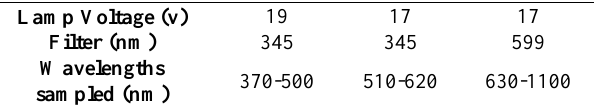
Table 2: Monochromator lamp voltage and internal filter settings used for specific wavelengths being